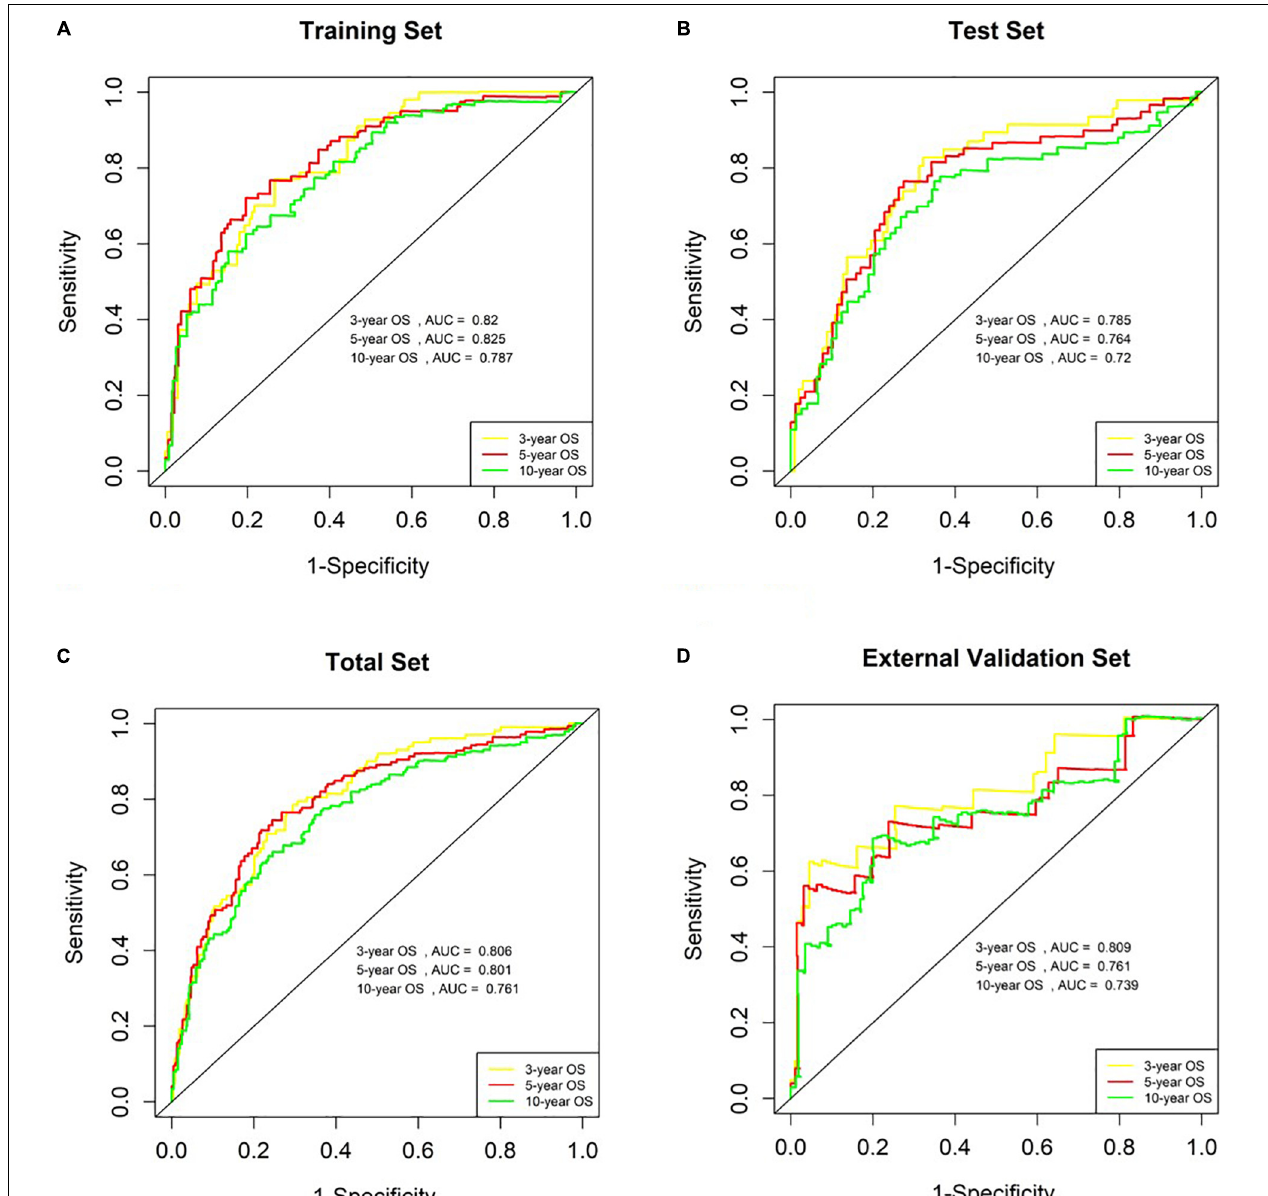
FIGURE 5 | Analysis of genetic risk score model in B-ALL patients. (A–D) Time-dependent ROC curves show AUC values at 3-year, 5-year and 10-year OS rate in training set, Test Set, Total Set, and External Validation Set, respectively.